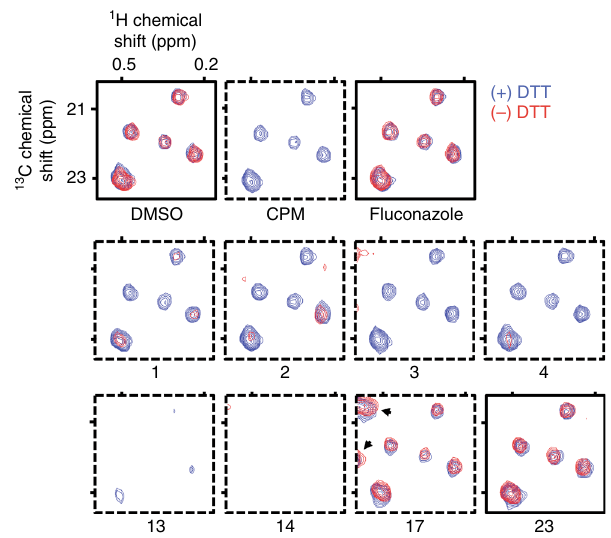
Fig. 1 Reported HAT inhibitors perturb the La antigen conformation as assessed by ALARM NMR. Compounds tested at 400 μ M fi nal concentrations. Signal intensities ( z -axis, relative units) normalized to DMSO control. Dashed border, positive readout. CPM ( N -[4-(7- diethylamino-4-methylcoumarin-3-yl)phenyl]maleimide), positive thiol- reactive compound control; fl uconazole, negative thiol-reactive and aggregation compound control. Note treatment of the La antigen with compound 17 results in several new peaks independent of DTT (arrowheads). Data are representative results from one experiment performed with two technical replicates. See Table 1 for additional